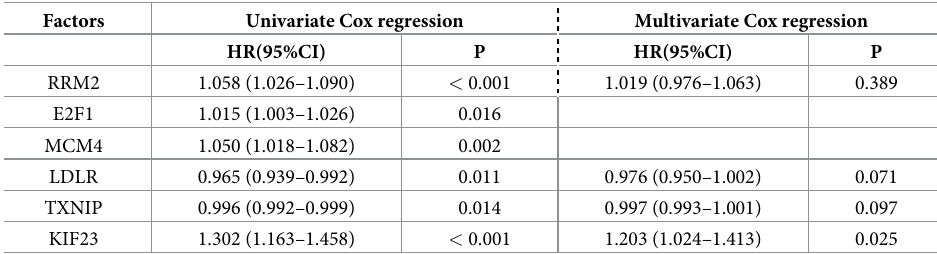
Table 1. The Cox regression analysis of key